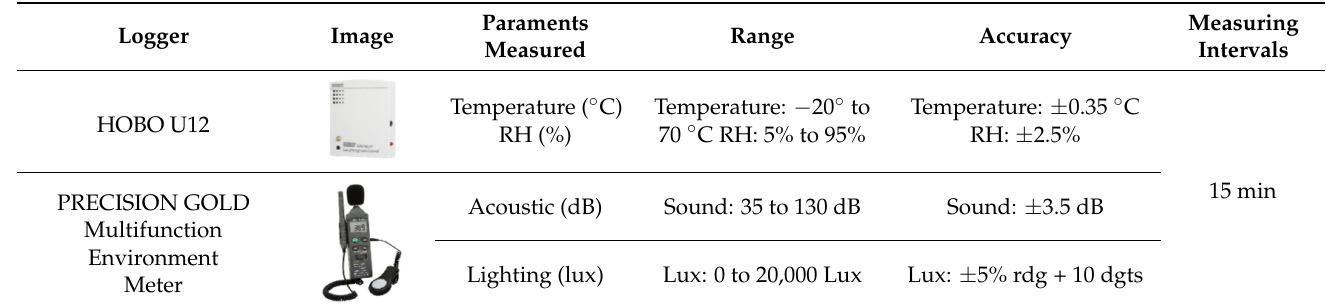
Table 2. Data loggers and specification.